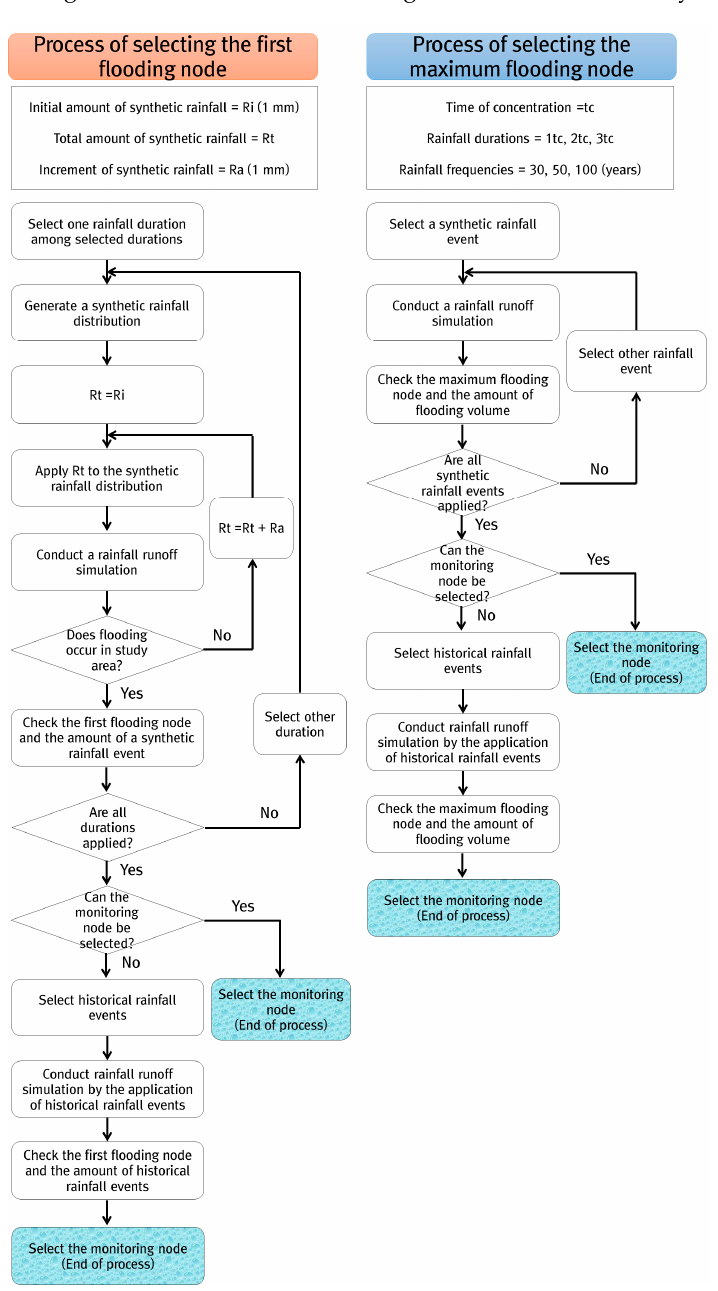
Figure 3. Process for selecting the first and maximum flooding nodes.